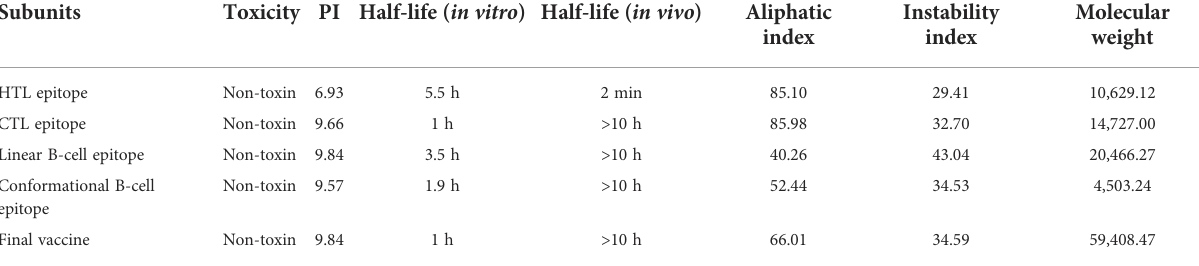
TABLE 8 Evaluation of the toxicity and physiochemical parameters of the